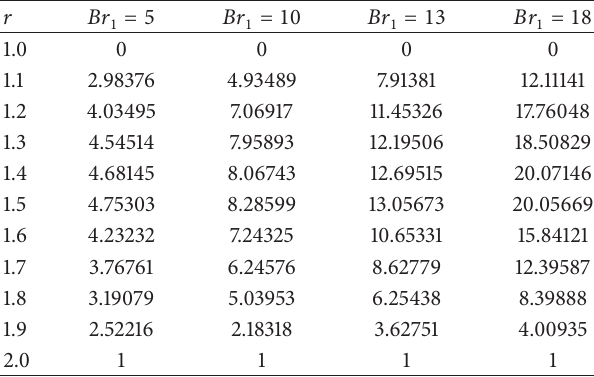
Table 6: Temperature distributions for several values of conductiv- ity ratio 𝐾 , when 𝛽 1 = 0.1 , 𝛽 2 = 0.3 , 𝐵𝑟 1 = 10 , 𝐵𝑟 2 = 15 , 𝜆 = = −0.001243429 , 𝐶 = −0.000248121 , 𝐶 0.3 , 𝛿 = 2 , 𝐶 1 2 = 0.000294127 . 0.001032981 , and 𝐶 4